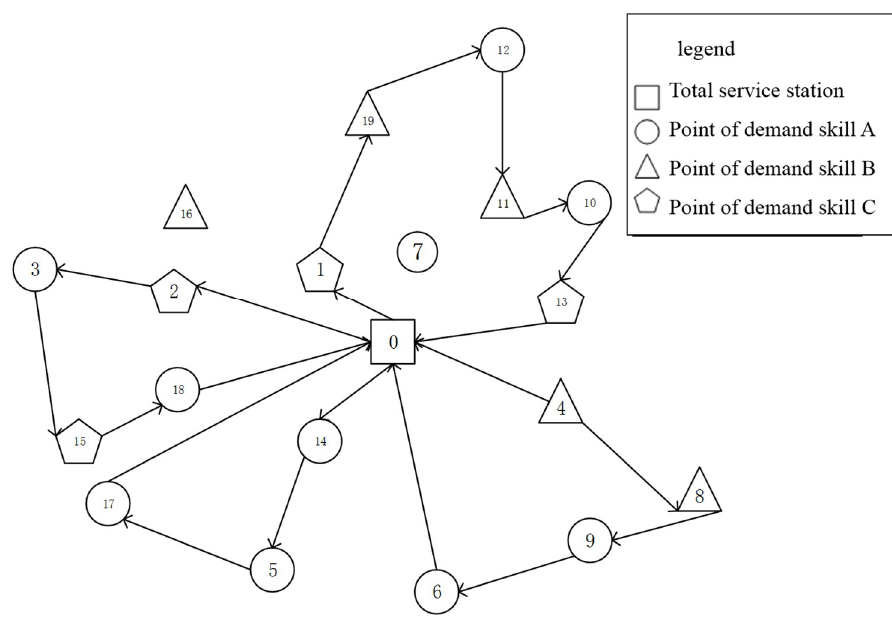
Figure 1. Multi-skilled human resource path problem.